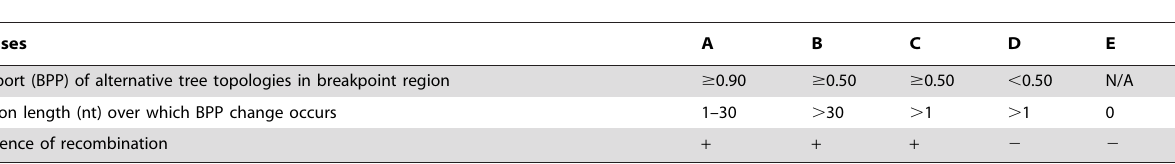
Table 1. Classification of results in breakpoint